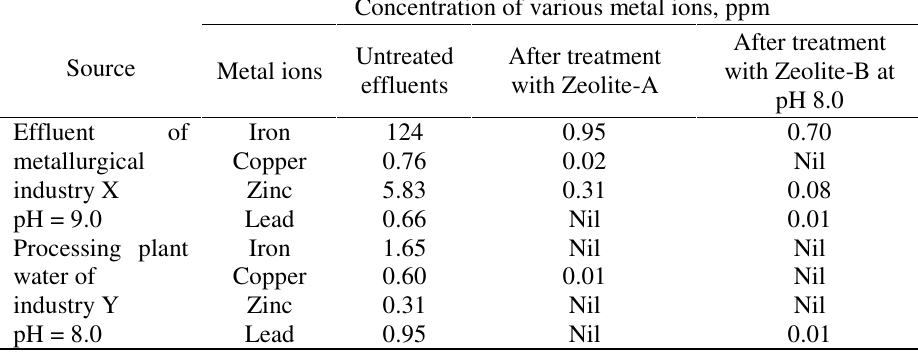
Table 5. Removal of toxic metal ions from the effluents from various mineral and metal processing industries. (The contact time for the reaction was 6 hrs used for the below